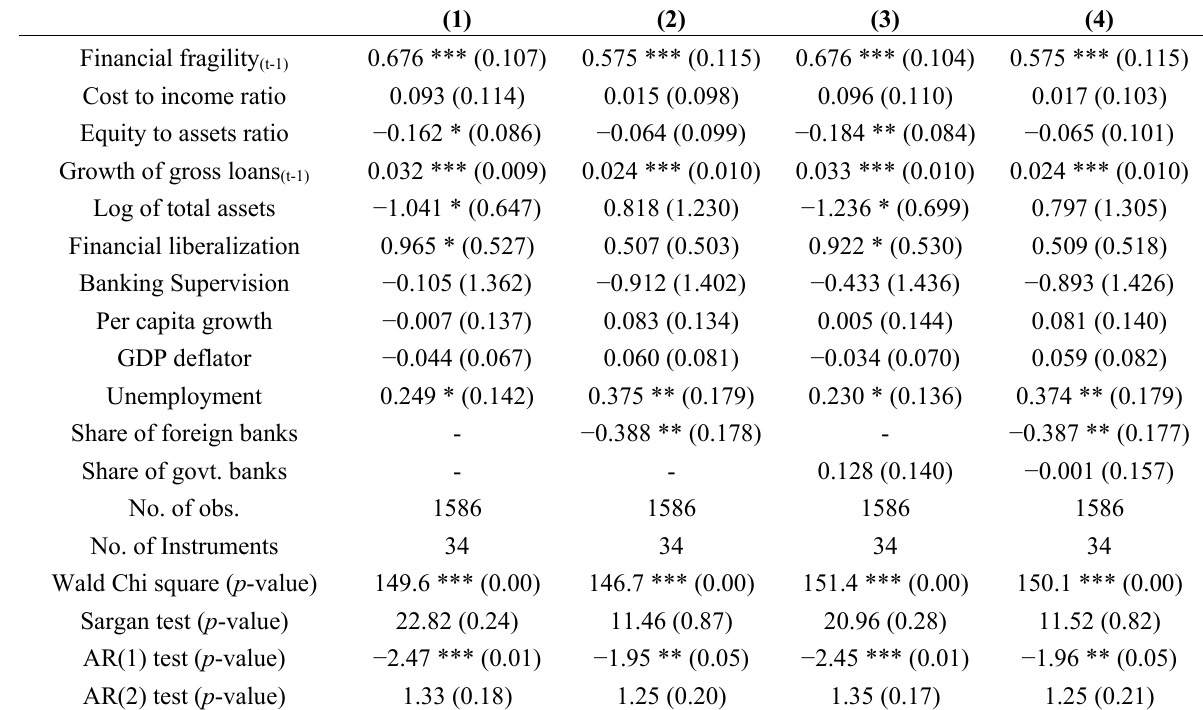
Table 6. Dynamic panel estimation of financial fragility with financial liberalization and banking